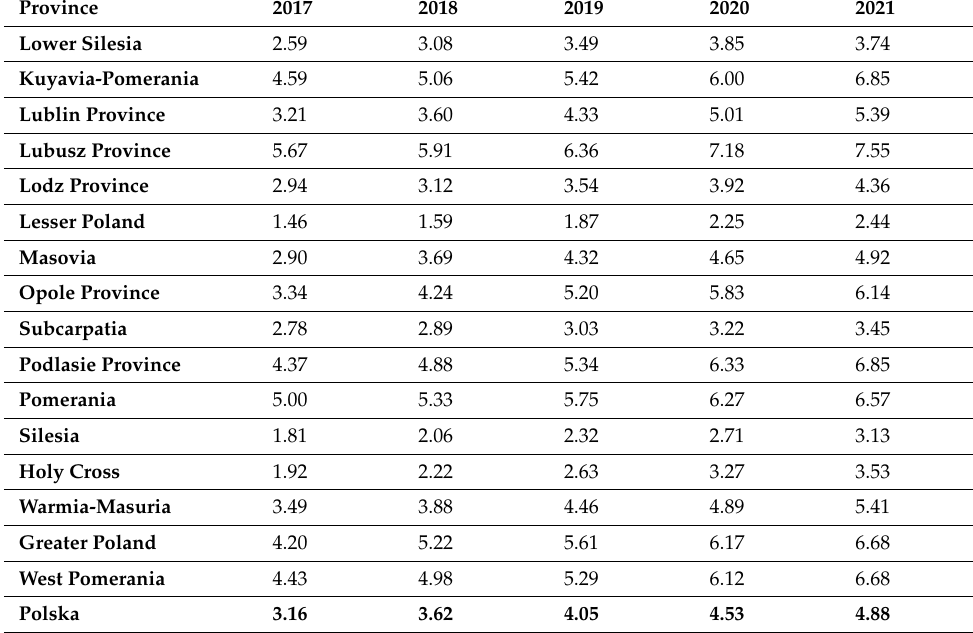
Table 4. Bicycle roads of Poland per 10,000 inhabitants in years 2017–2021.